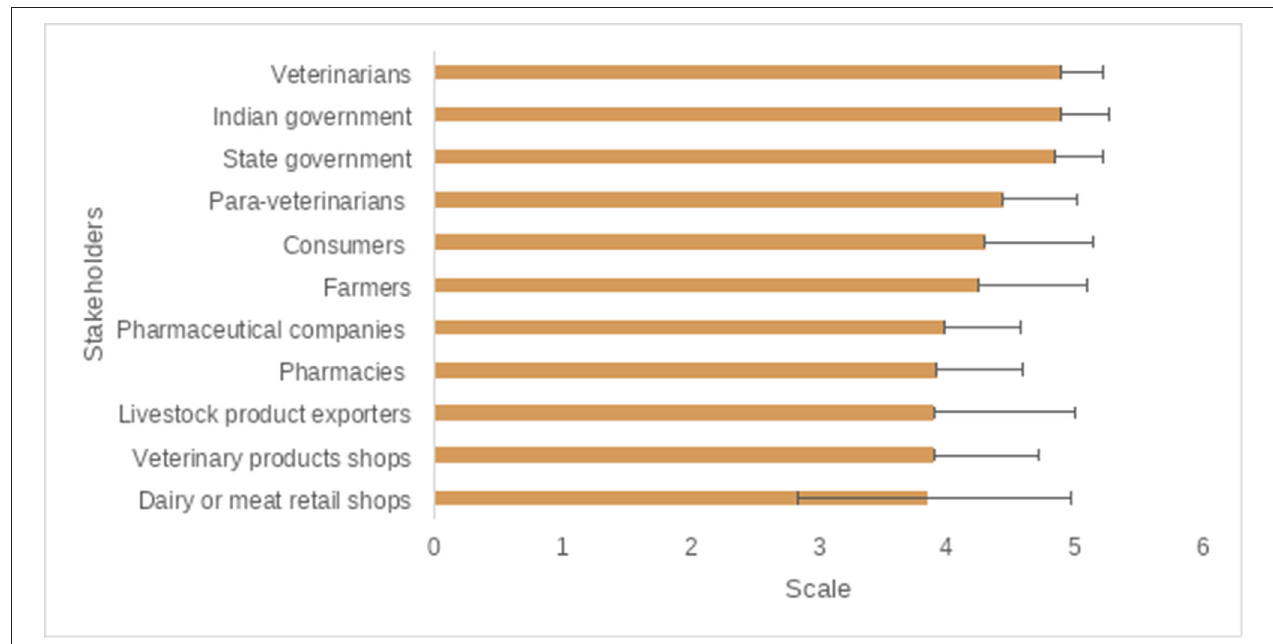
FIGURE 9 | The main/key stakeholders to control the excess use of antibiotics/antimicrobials, questions were scored on a 5-poinet Likert scale (1 = Not important; 2 = Slightly important; 3 = Fairly important; 4 = Important; 5 = Very important), the mean score is displayed here from lowest to highest.